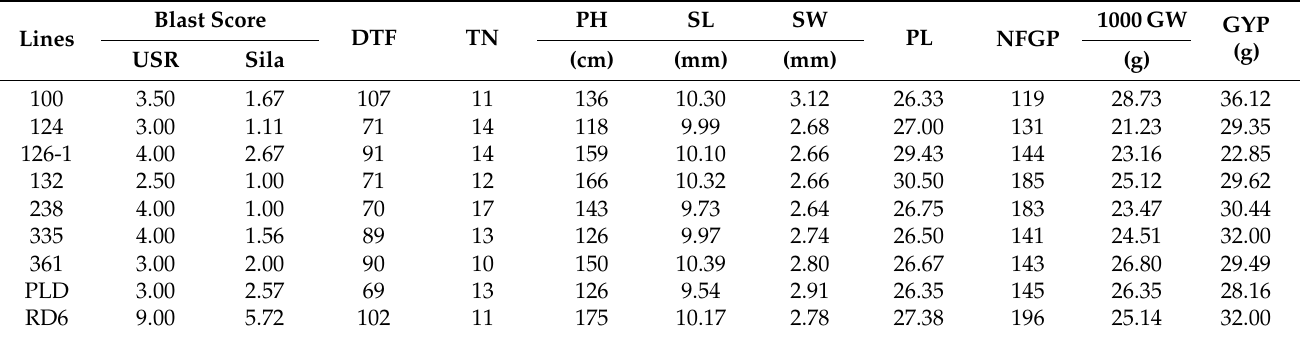
Table 5. Blast scores and agronomic traits of selected